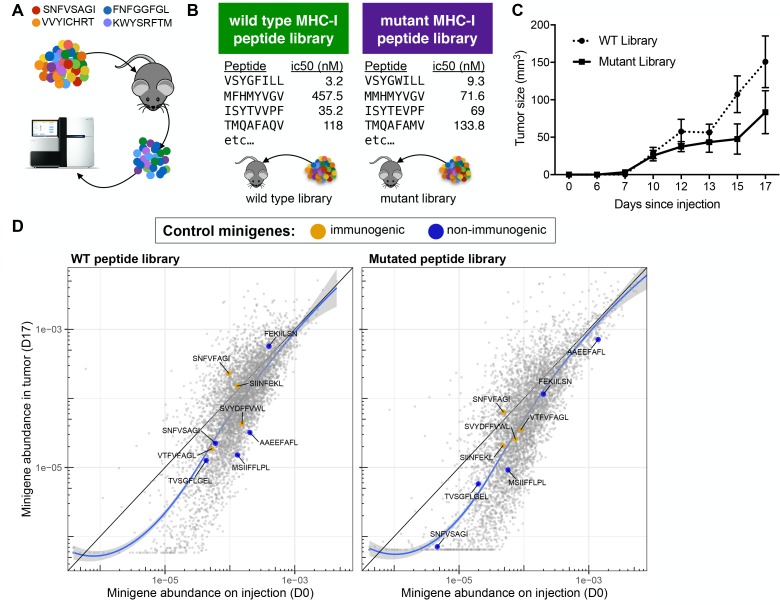
A drop-out screen for MHC-I peptide immunogenicity in immunocompetent mice.(A) Schematic of the drop-out screen for MHC-I immunogenicity. Mice were injected with mixtures of RMA/S cells, each of which expresses a different peptide that also served as a genetic barcode for later deconvolution. (B) Two libraries of mouse MHC-I peptides were constructed. Left: Wild type peptides identified by searching the mouse proteome for peptides predicted to bind to MHC-I (NetMHCpan H-2Kb ic50 <500 nM). Right: single amino acid mutants of each of the wild type peptides. (C) C57BL6/N mice (n = 5 per group) were injected with 5 × 106 cells bearing libraries of wild type or mutant peptides and tumor growth monitored. (D) A scatter plot showing the average frequency of each minigene in the library before injection of the cells (x-axis) and after growth of the tumor in wild type mice (y-axis). The abundance of each minigene before injection (n = 3) is plotted on the x-axis while the abundance of each minigene after 17 days of growth in a wild type mouse is plotted on the y-axis (n = 5). Orange circles indicate positive control (immunogenic) minigenes; blue circles indicate negative control (non-immunogenic) minigenes. The straight black lines indicate x = y. LOESS (local best fit) lines are plotted in blue. The abundance of each minigene plotted is an average of all biological replicates.10.7554/eLife.41090.006Figure 3—source data 1.Abundance of each minigene in the pretumor and tumor samples.